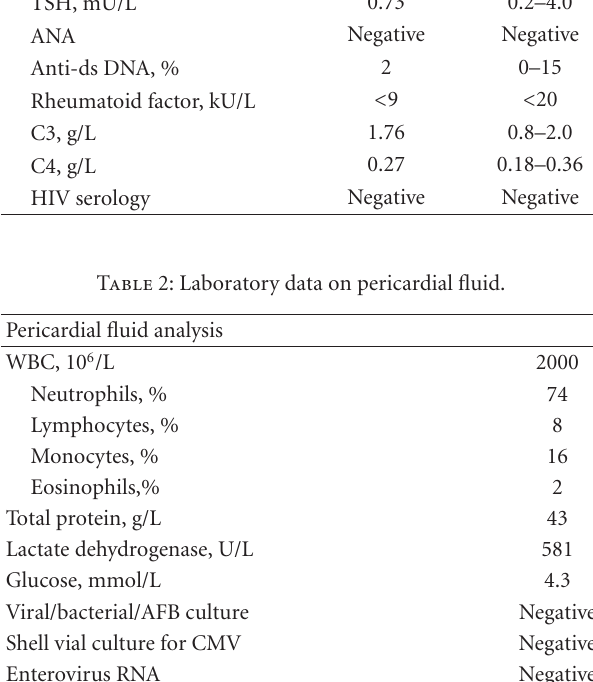
Figure 1: CT scan showing pericardial (dashed arrow) and bilateral pleural e ff usion (solid